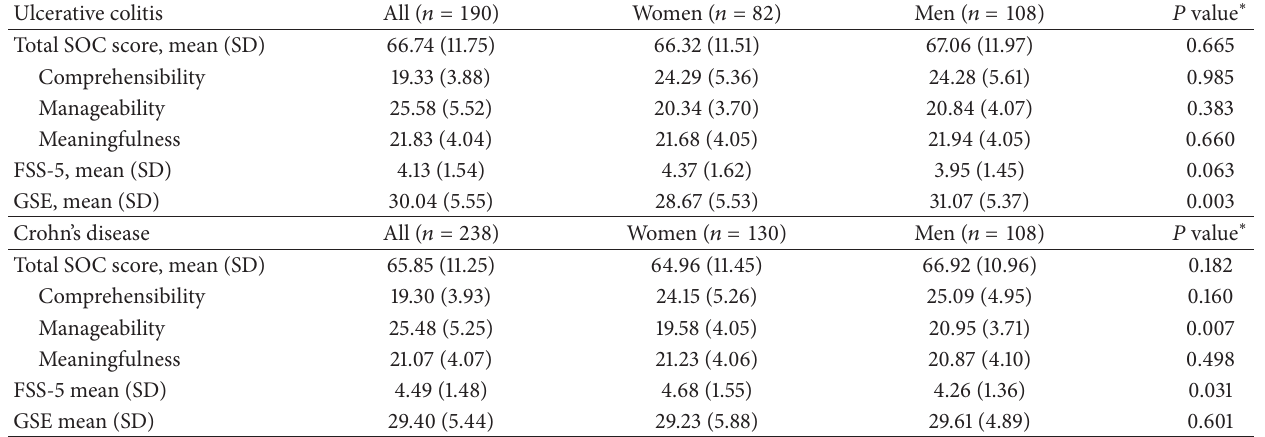
Table 2: SOC, FSS-5, and GSE scores in patients with ulcerative colitis and Crohn’s